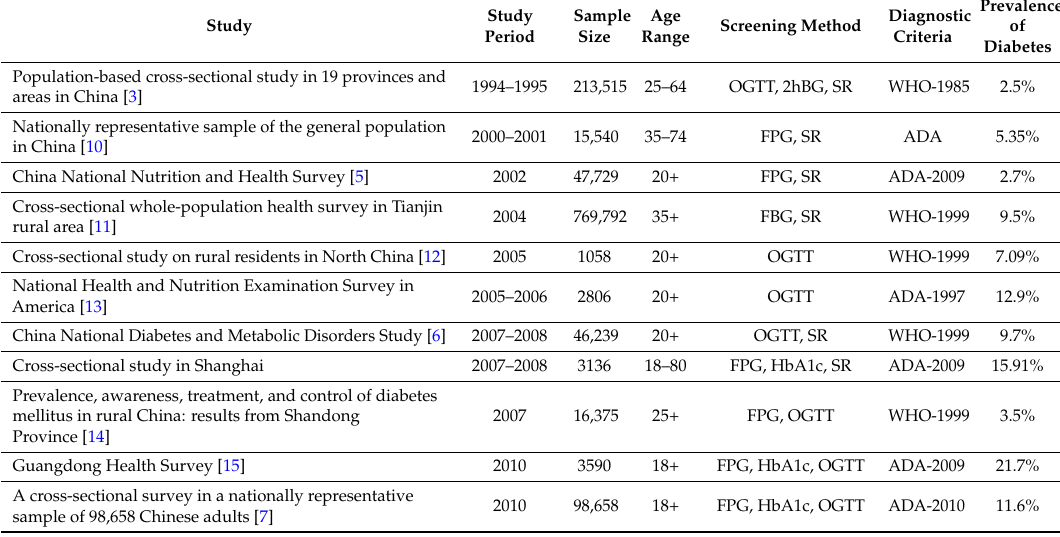
Table 1. Studies for diabetes in China and America. Study